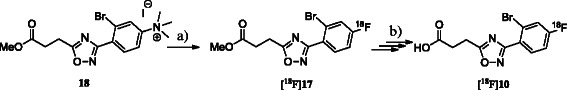
Radiosynthesis and metabolism of [18F]17. (a) Radiolabelling with K[18F]F-K2.2.2-carbonate complex (5.6 mg, 15 μmol), 2 mg of 18, MeCN, 82°C, 10 min; (b)in vivo metabolism.